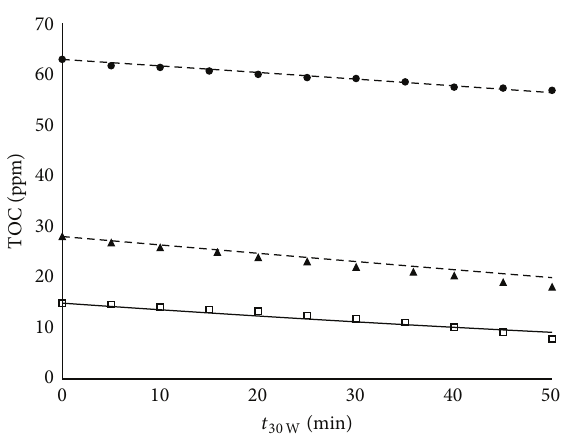
Figure 5: Experimental fitting of the modified model for 4-CP: 30 ppm ( ◻ ); 60ppm ( 󳵳 ); 120ppm ( ∙ ).